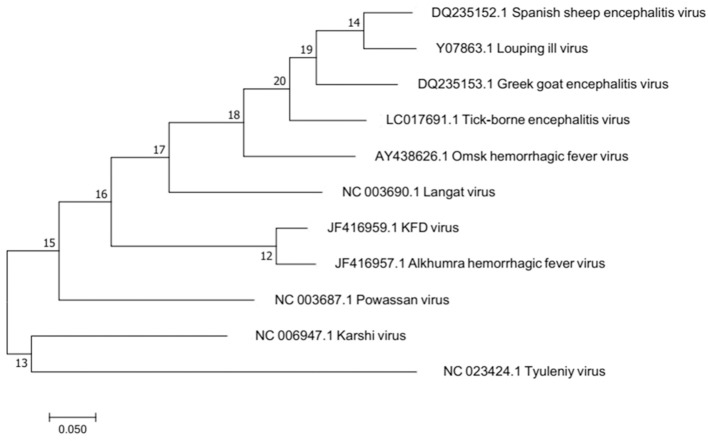
Molecular phylogenetic analysis by Maximum Likelihood method. The evolutionary history was inferred by using the Maximum Likelihood method based on the Tamura-Nei model. The tree with the highest log likelihood is shown. Alkumra hemorrhagic fever virus can be seen as the most closely related neighbor to KFD in the phylogenetic tree.